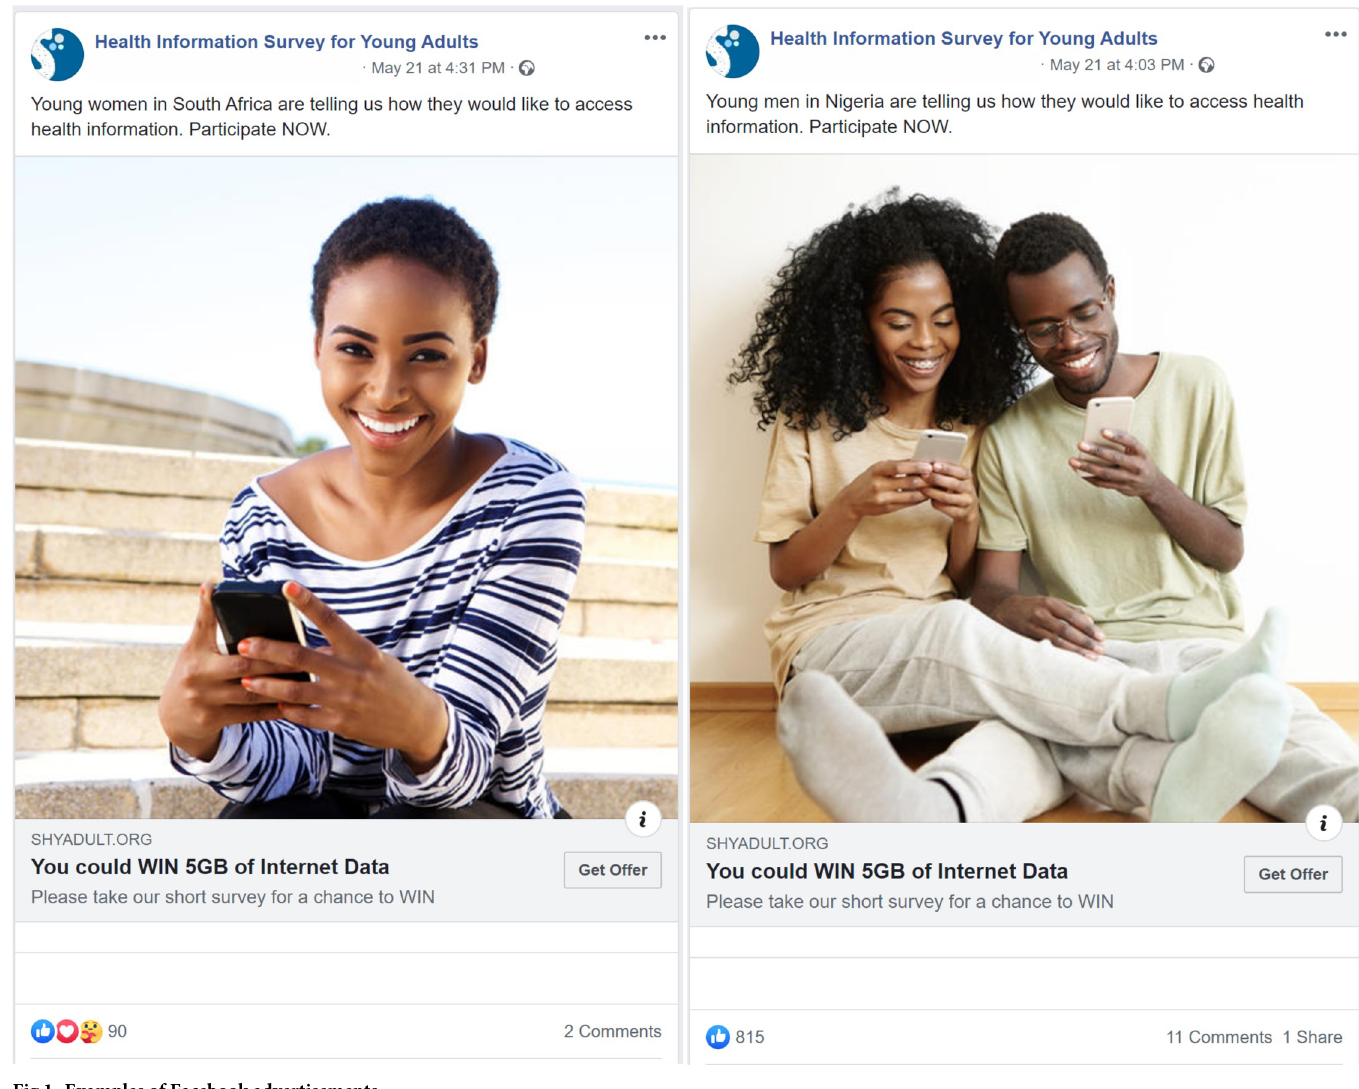
Fig 1. Examples of Facebook